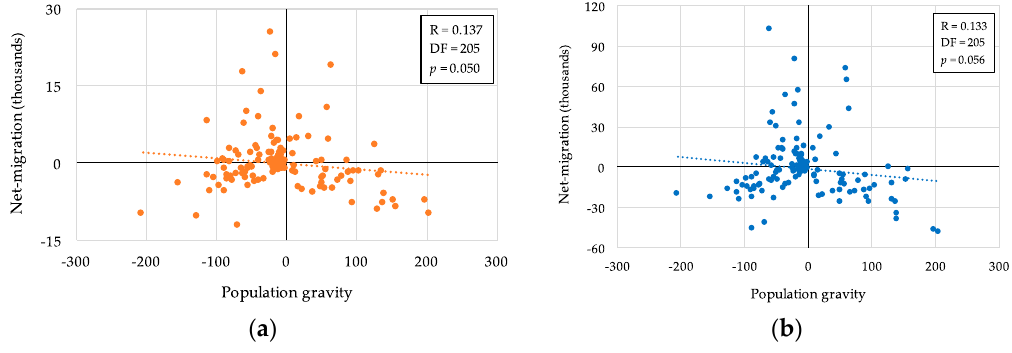
Figure A5. Population gravity in 2010 by the traditional gravity model with a power function and observed net migration: ( a ) in 2011; and ( b ) during 2011–2015.